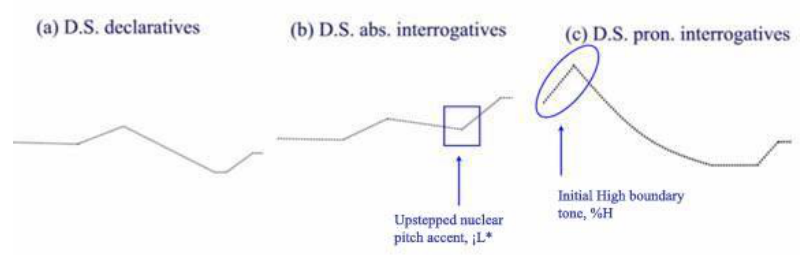
Figure 8. Schematic of the basic broad focus intonational contours of declaratives, absolute interrogatives, and pronominal interrogatives in Dominican Spanish with proposed tonal targets for distinguishing tonal levels.